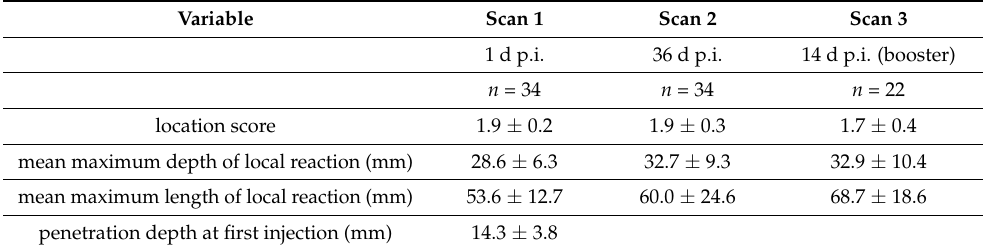
Table 3. Results of the linear measurements and the location